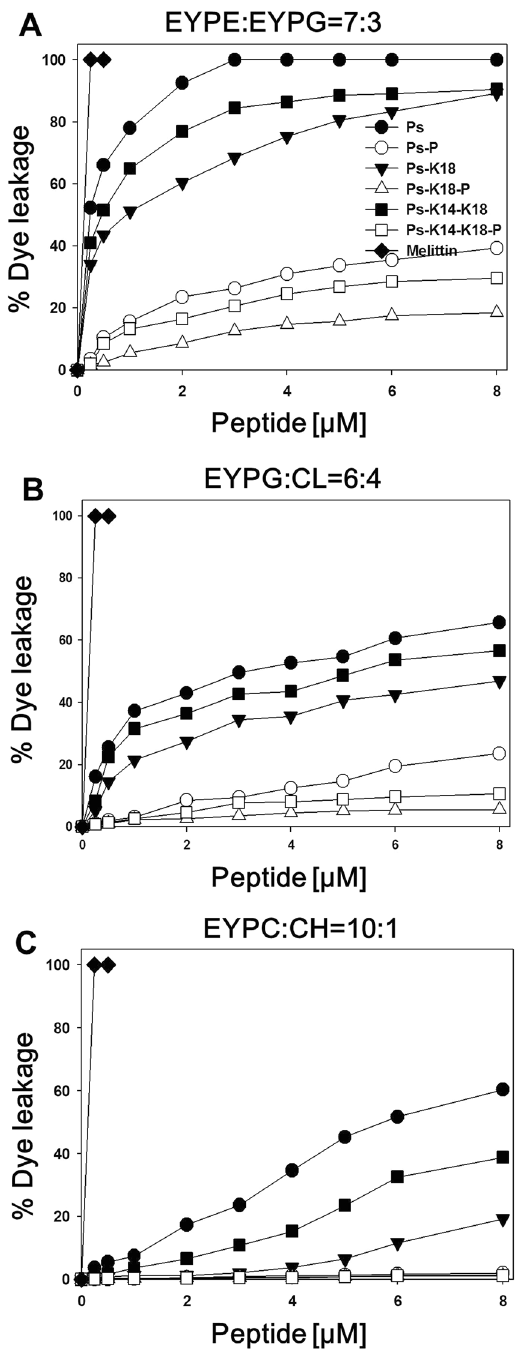
Figure 3. Concentration-response curves of calcein leakage induced by the peptides from ( A ) egg yolk phosphatidylethanolamine (EYPE)/egg yolk phosphatidylglycerol (EYPG) (7:3, w/w), ( B ) EYPG/cardiolipin (CL) (6:4, w/w) and ( C ) EYPC/cholesterol (CH) large unilamellar vesicles (LUVs; 10:1,